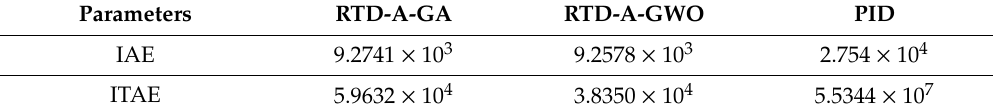
Table 11. Performance comparison of the gain scheduled RTD-A and PID for the conical tank.